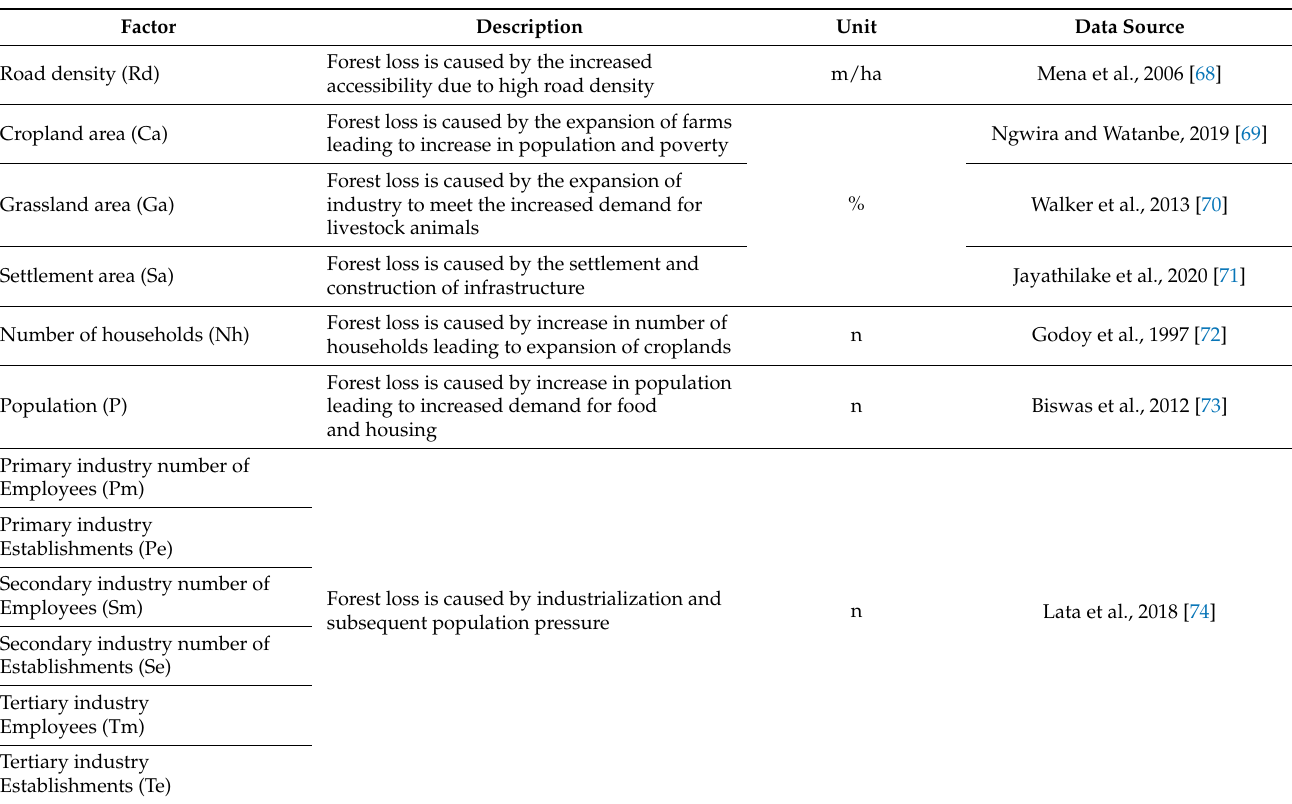
Table 3. Impact factors of forest